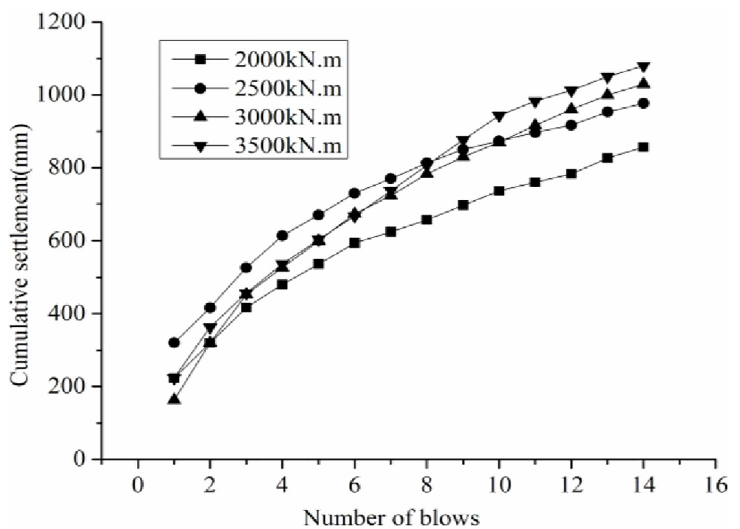
Fig 9. The cumulative tamping settlement curve with varying tamping